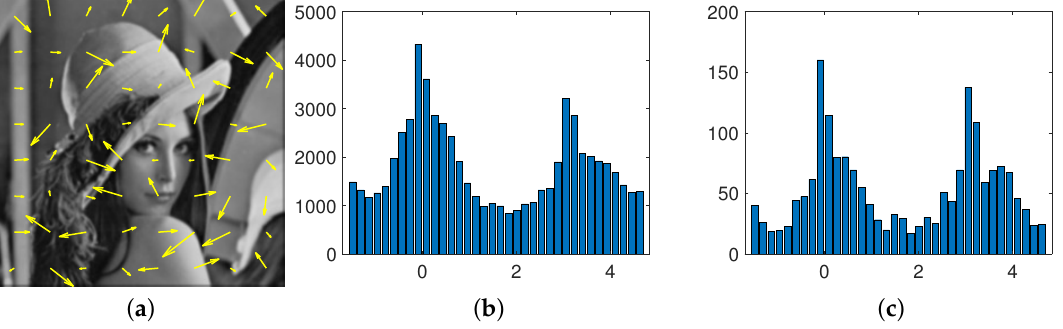
Figure 4. Gradient field statistics: ( a ) a gradient field on Lena image; ( b ) a traditional histogram; ( c ) the weighted